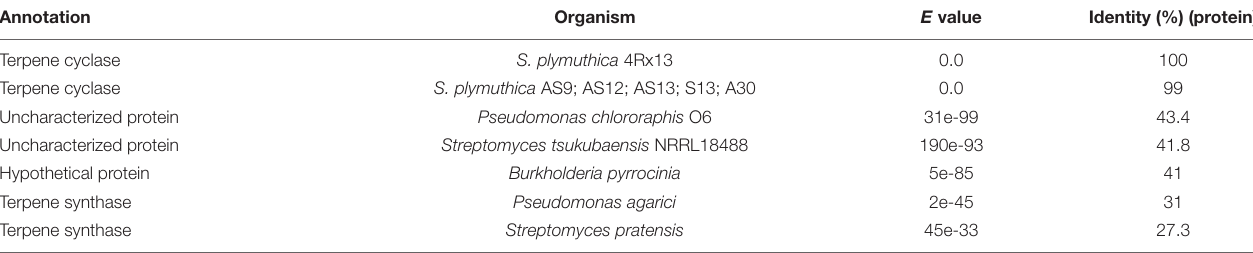
TABLE 2 | Homologs of SOD_c20750 (terpene cyclase) of Serratia plymuthica 4Rx13 in other bacteria.